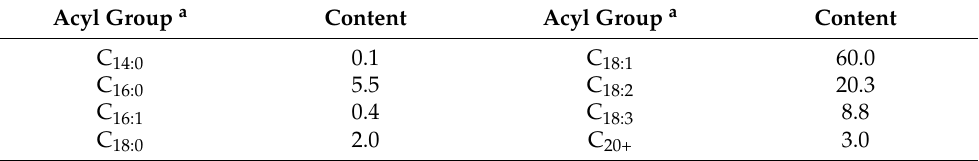
Table 12. The distribution of the acyl groups in the RO used as a component of the F20 feedstock (wt %).